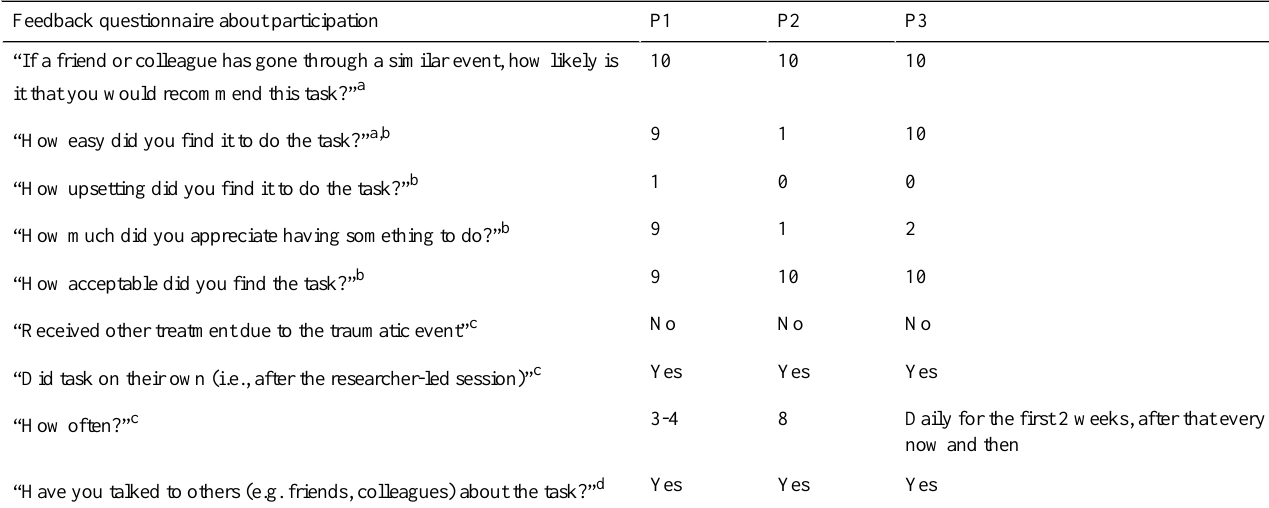
Table 2. Responses on feedback questionnaire about participation from each participant at 1